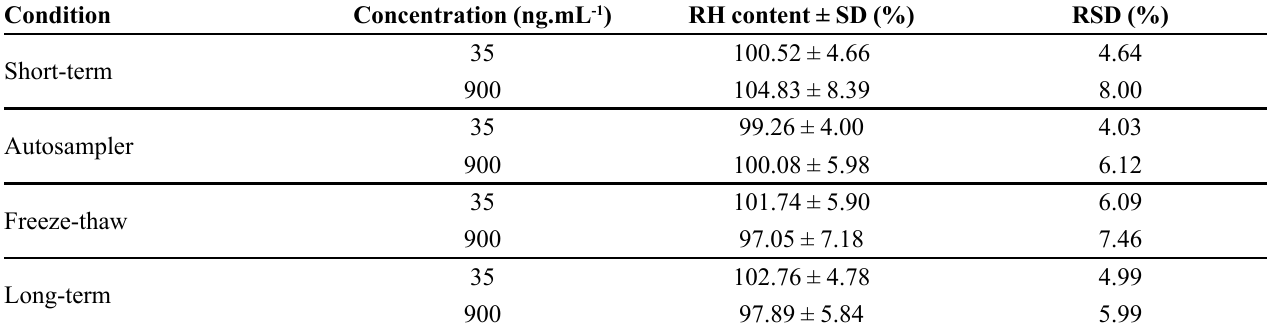
TABLE II - Stability of RH in rat plasma at two quality control levels (n = 3)